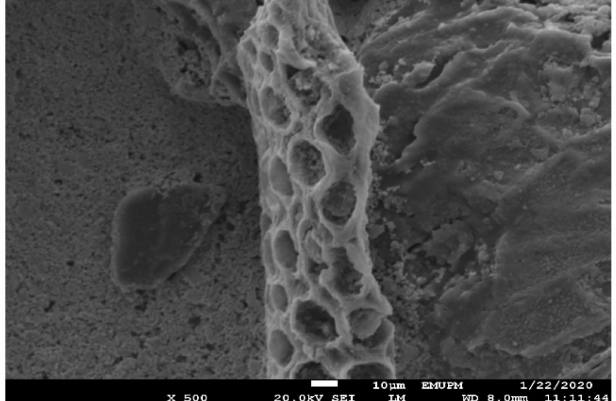
Figure 16. SEM image of the spent catalyst after the fifth